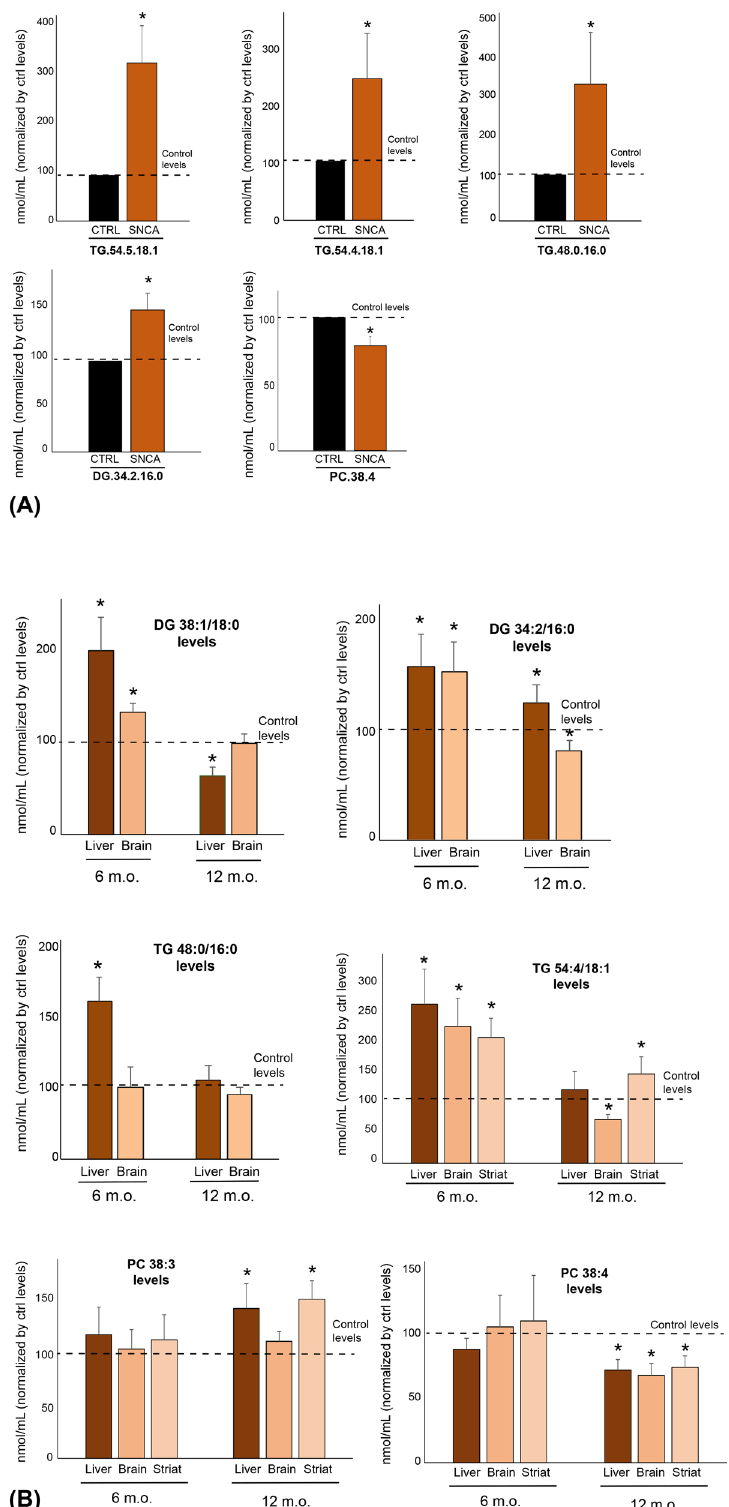
Fig. 4 Changes in lipid species in SNCA G209A cells and transgenic mice: triradylglycerol (TG), glycerophosphatidylcholine (PC), and diradylglycerol (DG). a Concentrations of lipid species showing signi fi cant changes in SNCA G209A neuroblastoma cell lines versus control lines ( n = 4 biological replicates ± SD each run in triplicates. * p < 0.05, t test. CI 95%). b Concentrations of lipid species in tissues from SNCA G209A transgenic mice versus tissues from SNCA transgenic and non-transgenic mice ( n = 3 biological replicates ± SD each run in triplicates * p < 0.05. t test. CI 95%). The levels of some species were undetectable in striatum samples and were not included in the